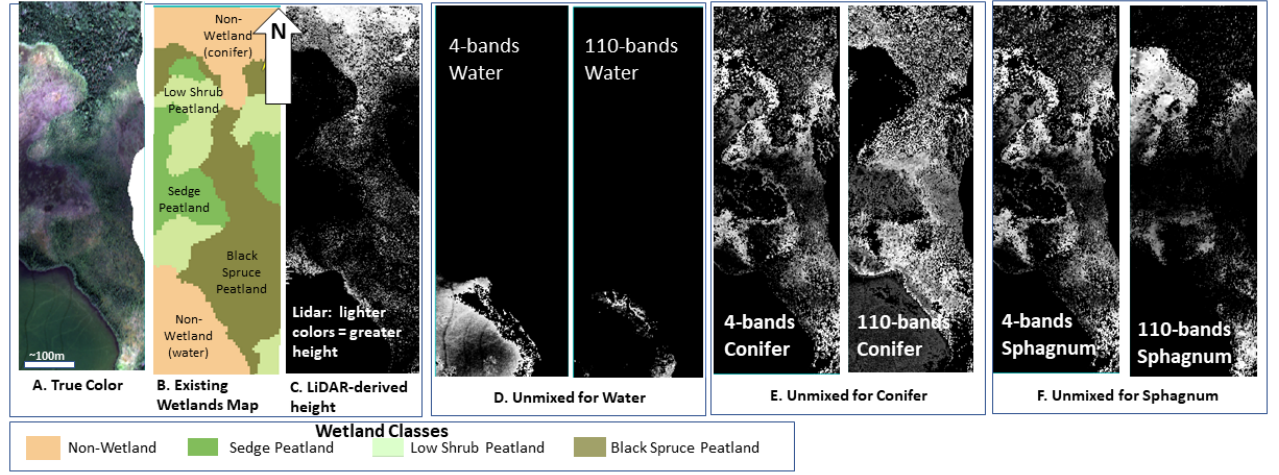
Figure 9. Comparison of a ( A ). G-LiHT true color image, ( B ). Existing Wetlands Map ([21]) ( C ). G-LiHT LiDAR-derived heights, to the unmixing results for the 4-band unmixing (left) and the 110-band unmixing (right) ( D ). Water, ( E ). Conifer, ( F ). Sphagnum